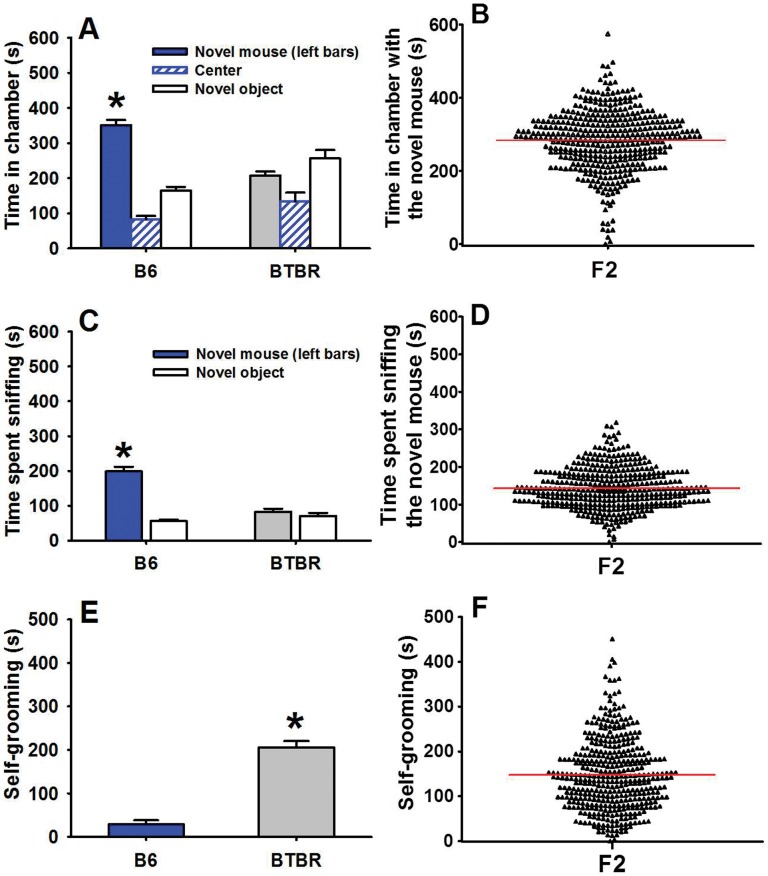
Adult social approach in B6, BTBR, and F2 mice.(A) B6 exhibited high sociability, spending significantly more time in the chamber containing the novel mouse than in the chamber containing the novel object, and (C) more time sniffing the novel mouse than the novel object. BTBR exhibited low sociability and did not show preference for the novel mouse. (E) As compared to B6, BTBR mice exhibited significantly higher levels of self-grooming in an empty cage. In the present study, F2 mice exhibited broad ranges of time spent in the novel mouse chamber (B), time sniffing the novel mouse (D), and self-grooming in an empty cage (F). The parental strains and F2 generation were tested using identical methods, by the same NIMH investigators in the Bethesda laboratory. The F2 scores shown in panel B and panel D represent the time spent in the chamber with the novel mouse Panel A and the time spent sniffing the novel mouse and time spent sniffing the novel object in Panel C, respectively. (A, C)*p<.05 for the comparison between novel mouse and novel object; (E)*p<.01 vs. B6. A, C, E display Mean ± SEM; bold red line in B, D, F indicates mean value. B6 and BTBR data from A, C, and are adapted from Yang et
al., 2009, European Journal of Neuroscience, Copyright (c) 2009, Blackwell Publishing, Ltd., with reuse and reprint permission via the Copyright Clearance Center (CCC).